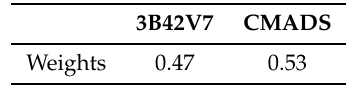
Table 6. BMA weights of simulated streamflow forced by different precipitation